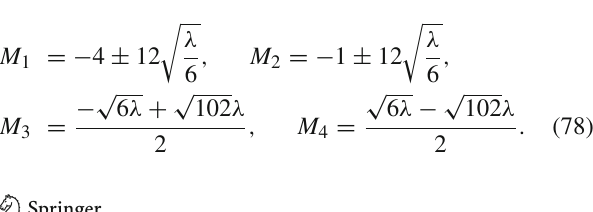
For the critical points of Table 7, eigenvalues obtained Figure 4, shows that the phase portrait diagram for the